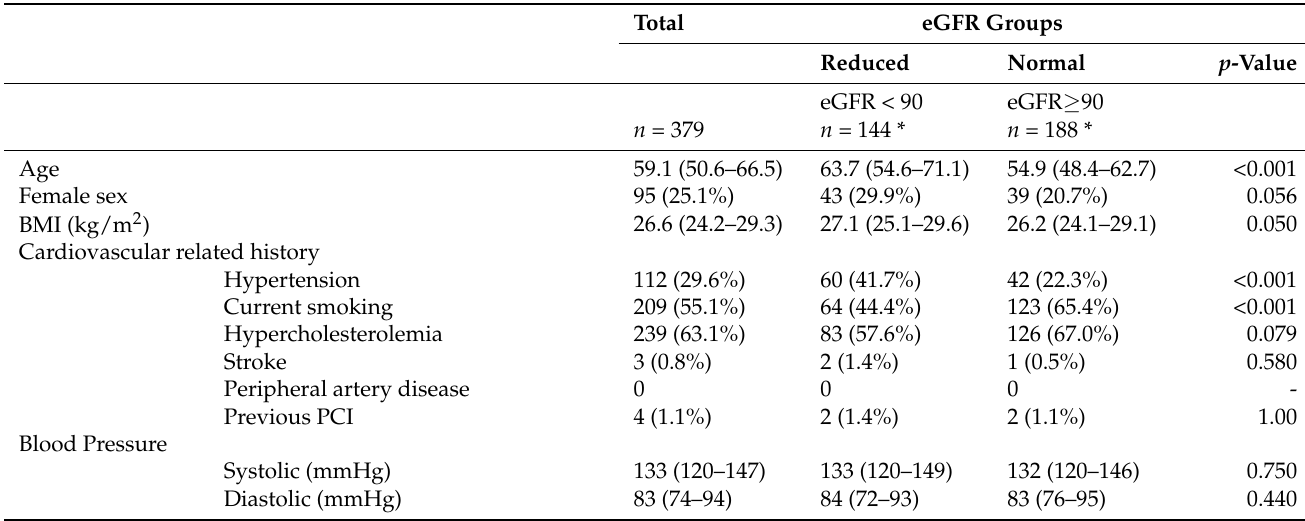
Table 1. Baseline characteristics of GIPS-III